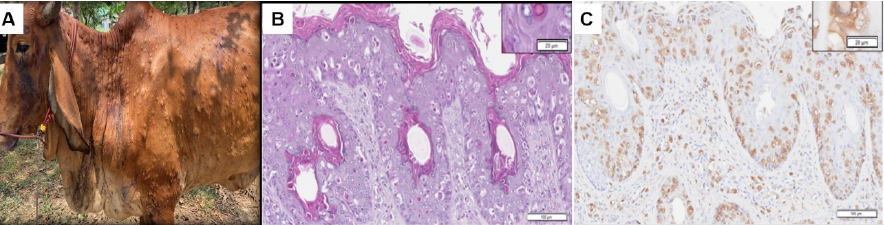
Figure 1. Clinical signs and histopathological examination of LSD-infected animals. ( A ) Skin nodules all over the body surface of a beef cattle. The nodules are 1–3 cm in diameter, circumscribed, round, and slightly raised. ( B ) Haematoxylin and Eosin (H&E) staining histopathological lesions demonstrating epidermal hyperplasia with hyper-eosinophilic cytoplasm and large numbers of spongiotic keratinocytes containing large, round eosinophilic intracytoplasmic inclusion bodies were found dispersed throughout the affected skin. The dermis and hypodermis were infiltrated by inflammatory cells. Moderate to severe dermal vasculitis and perivascular accumulation of inflam- matory cells and fibrins were observed. The high magnification views (dashed boxes) depict the epidermis. ( C ) IHC of the corresponding areas in the consecutive tissue section is shown in B. The brown staining of LSDV antigens accumulated in the cytoplasm of the infected cells is shown in the inset. 3.2. Distribution of LSD Since the confirmed case in north-eastern Thailand in March 2021 [21], we investi- gated and collected data on LSD cases based on clinical signs, real - time PCR, and serolog- ical tests up until June 2022 via the E - smart Surveillance system . There were 628,089 af- fected animals and 283,212 affected farmers (data retrieved from DLD on 30 June 2022). During the first five months of the outbreak from March to July 2021, the percentage of LSD-positive provinces varied dramatically by month ( p < 0 . 0001 ). The disease spread from the first outbreak in the northeast to four nearby provinces in three days . In April, the number of LSD-affected provinces increased considerably ( p < 0 . 01 ) , as LSD expanded to nine adjacent provinces. Concurrently, new outbreaks distant from the events in the northeast occurred in 10 provinces in central, western and southern Thailand ( Figure 2, Tables S3 and S4, and Video S1 ). In May, the outbreaks expanded to 27 other provinces in four regions ( Figure 3A, Table S4 ). The number of newly-affected provinces decreased remarkably in June ( p < 0 . 01 ) and July ( p < 0 . 00001 ) to nine and four provinces, respec- tively. However, the number of new LSD cases reached a peak in June with almost 30,000 reported cases per day, and then reduced significantly in July (Figure 3B), corresponding to the vaccination campaign established in June 2021 . From August 2021 to June 2022, six provinces were affected by the disease, four of which were in the southern region (Figure 3A, Table S4). There were a few new cases during these 11 months (Table S3). In this wave, LSD spread to a total of 70 provinces in six regions of Thailand.